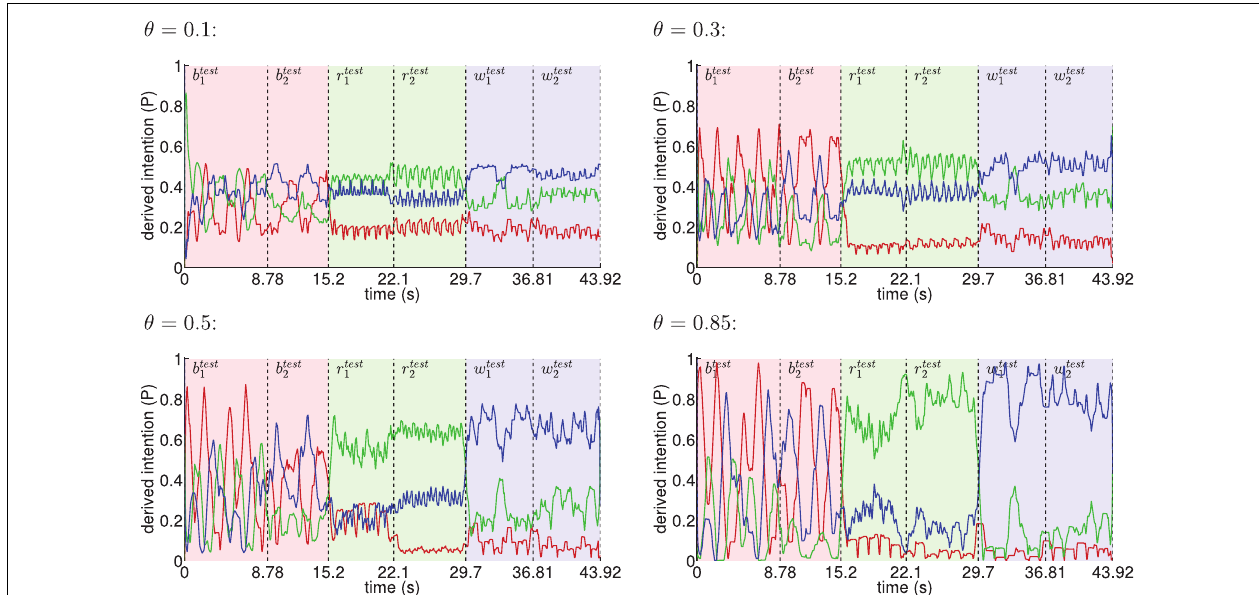
FIGURE 8 | Inference of intentions from visually observed movements shown for different (cid:18) . The red line indicates the moving average (one-second time window) of the derived basketball state probability in the intention layer, while light red background shows the interval in time the testing trials b 1test and b 2test were actually presented. Analogously, green indicates running and blue indicates walking . The classifier confidence improves with θ as a result of learning more disjunct sets of states per